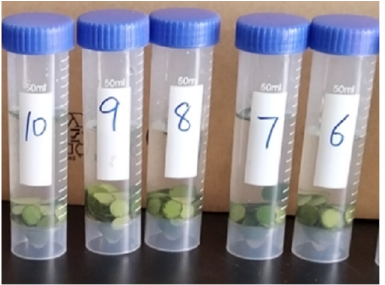
Figure 1. Leaf samples soaked in heavy metal solution.